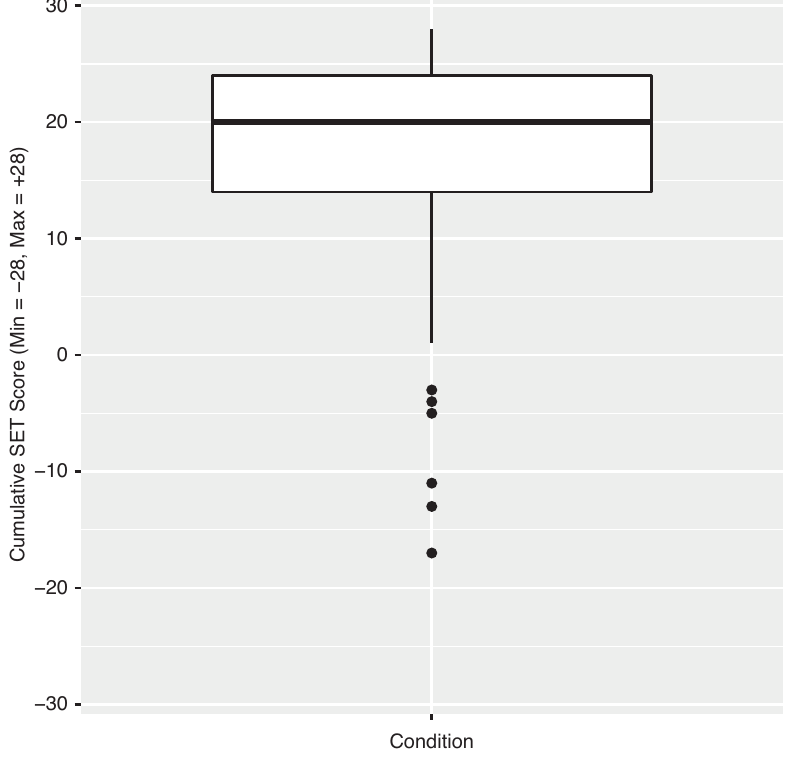
Figure 1. The boxplot of Khazan et al.’s recovered cumulative SET scores. The boxplot identifies six values as outliers, that is, the values more than 1.5 inter-quartile range from the quartiles. The outliers are the same six “negative” values used by Khazan et al. to claim gender bias against the female